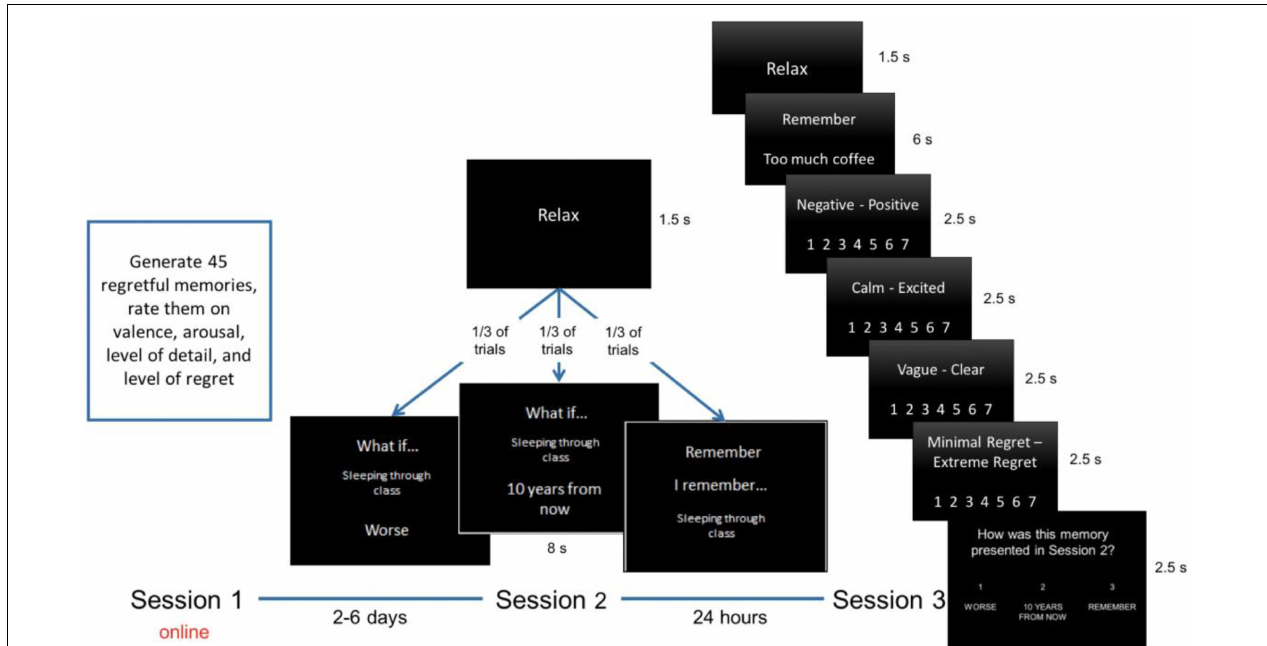
FIGURE 1 | Experimental methods outline. In Session 1, participants listed and rated 45 regretful memories from the past 5 years. In Session 2, participants came into the lab and either created worse alternatives (Downward CFT), imagined how they would feel about the memory in 10 years (Temporal Distancing), or simply recalled details of what occurred (Rehearsal). In Session 3, participants recalled their memories again and re-rated them on various phenomenological measures. They were also asked to recall which technique they had used to simulate the memory on the prior